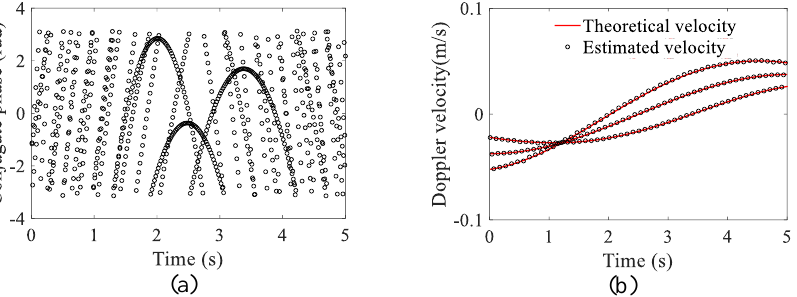
Figure 4. The result of MDCM method. ( a ) The initial phases of scattering points extracted from the radar range profile. ( b ) The estimated velocities derived from the conjugate phases by MDCM.